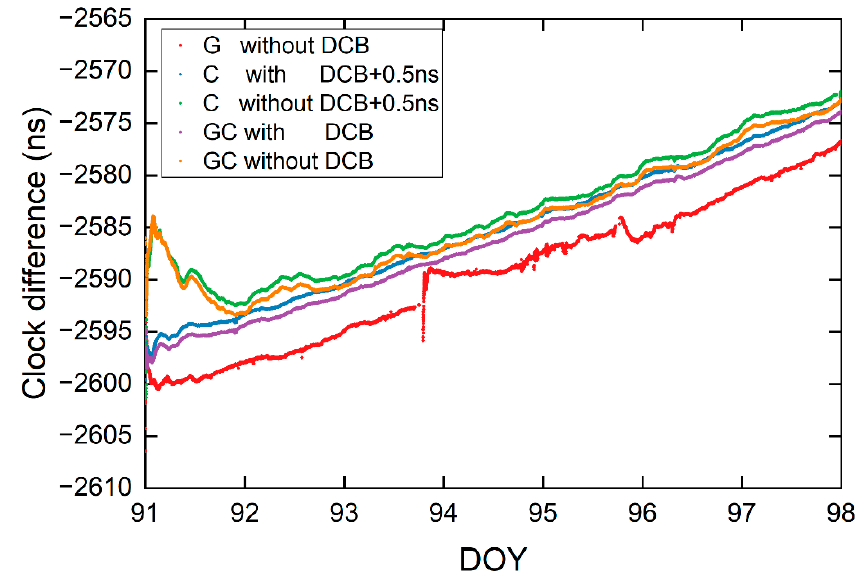
Figure 15. Clock difference of the B2b-RTPPP solutions for the TLM2-USUD time link.